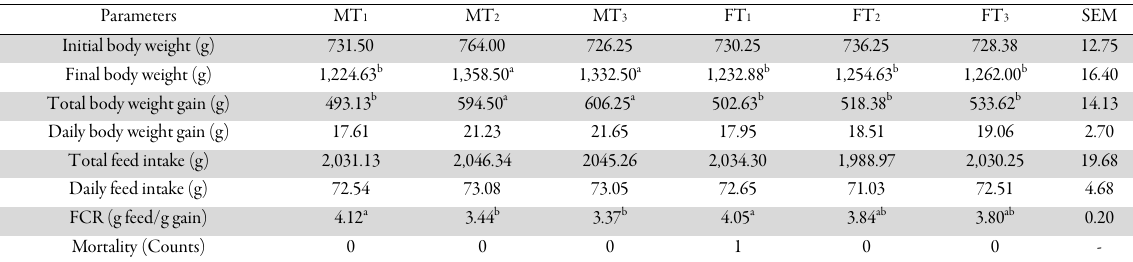
Table 2. Growth performance of growing rabbits administered Panax ginseng extracts Parameters